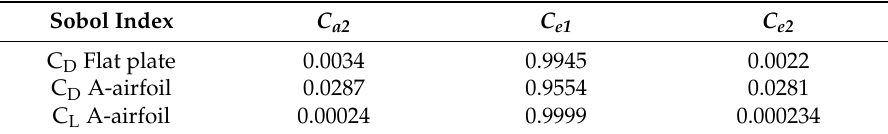
Table 11. Sobol index of three model coefficients for NISP.